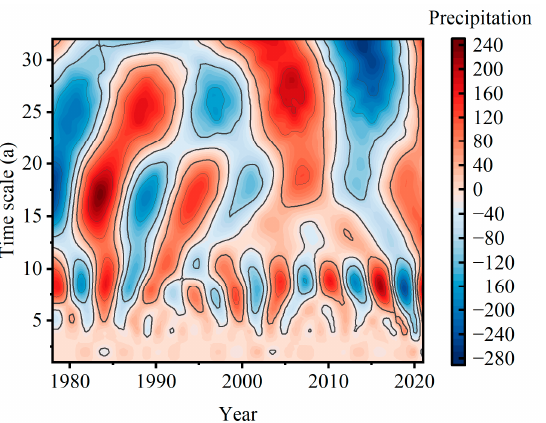
Figure 5. The wavelet transform coefficient graph of precipitation in Henan Province from 1978–2021 at the annual scale.